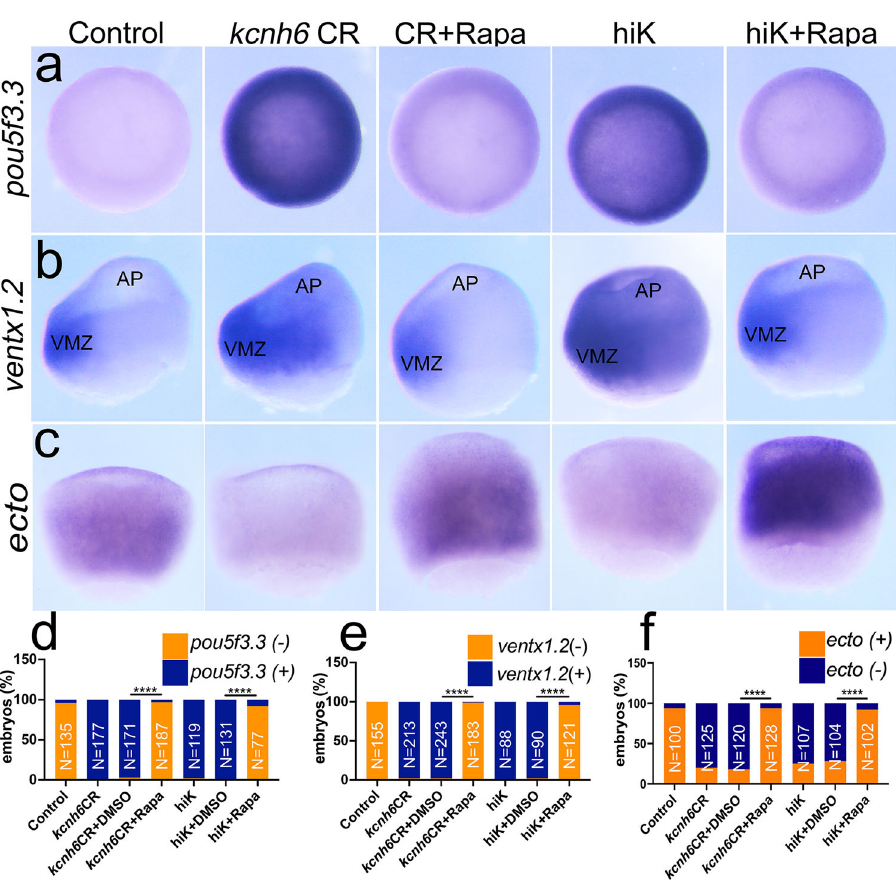
Fig. 7 |V m polarizationlimitsmTOR whichpromotespluripotency. a – c WMISH for pluripotencymarkers pou5f3.3, ventx1.2, and differentiation marker ectodermin in stage 10 embryos, depolarized by kcnh6 depletion ( kcnh6 CR) or high K+ (hiK), and treated with vehicle (DMSO) or rapamycin (Rapa) as indicated; views are a animalpole; b , c lateralviewwithdorsaltotheright;APanimalpole,VMZventral marginalzone. d – f Quanti fi cationofstage10embryoswithpresent(+)orabsent( − ) expressionofmarkers pou5f3.3 ( d ) ,ventx1.2 ( e ),and ectodemin ( f )intheanimalpole area. p -values in d are: ( kcnh6 CR+Rapa vs kcnh6 CR+DMSO)=3.34e-087 and